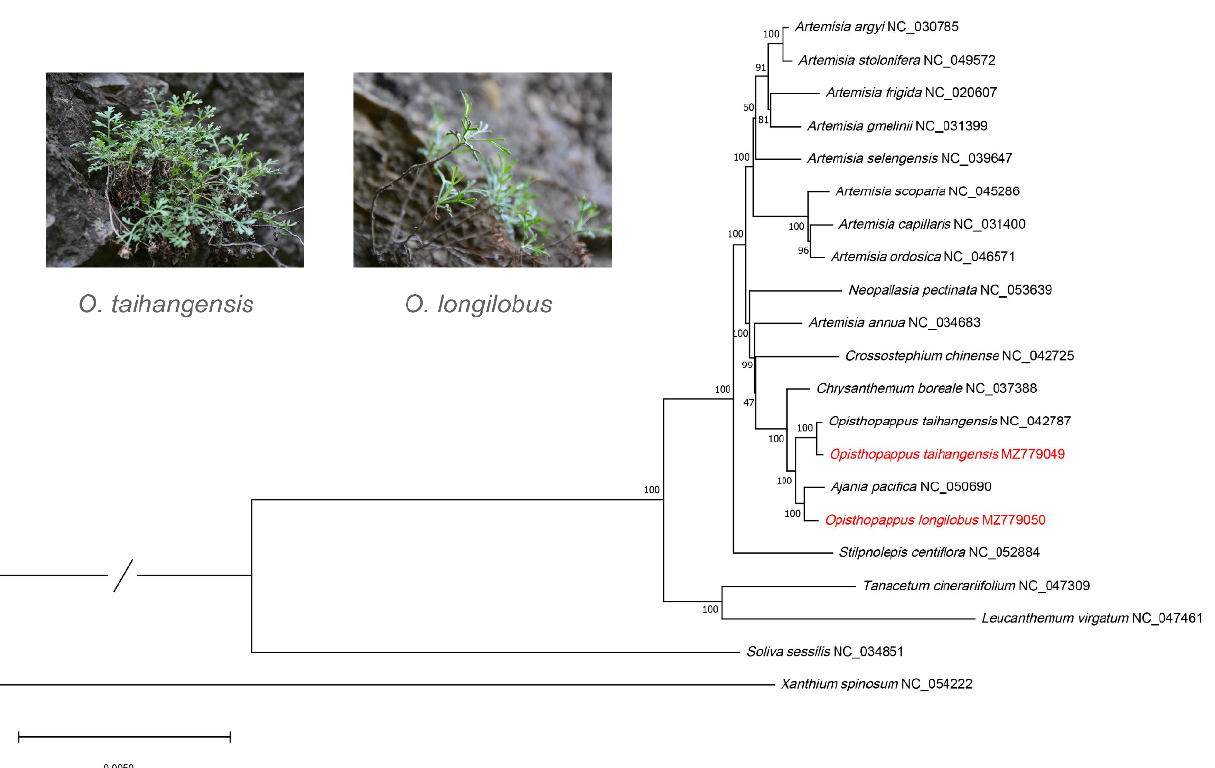
Figure 5. Divergence time estimation based on subtribe Chrysantheminae. 3.5. Comparative cp Genomic Analysis In order to explore the sequence divergence between the two species of Opisthopap ‐ pus , nucleotide diversity (Pi) was estimated to indicate the variability of potential plastid regions. The values of Pi ranged from 0 to 0.01. Among them, 124,370–126,369 bp resign